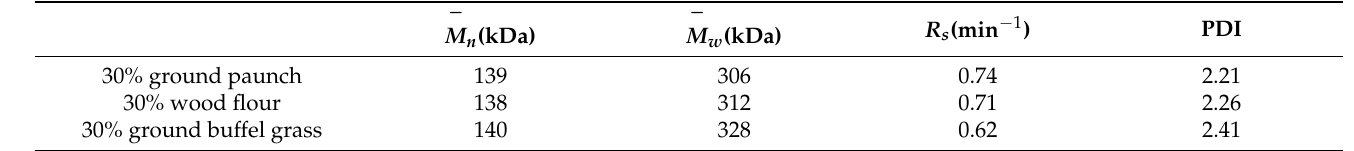
Table 5. Molecular weight values of PHBV in PHBV/ground paunch, PHBV/wood flour and PHBV/ground buffel grass composites at a fibre content of 30